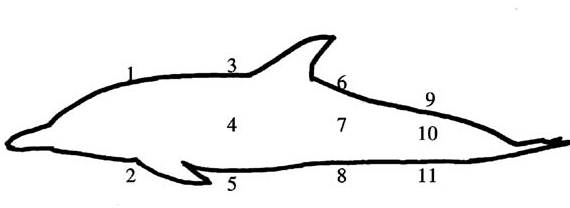
Fig. 1. – Blubber sampling locations in the striped dolphin ( S. coeruleoalba ).